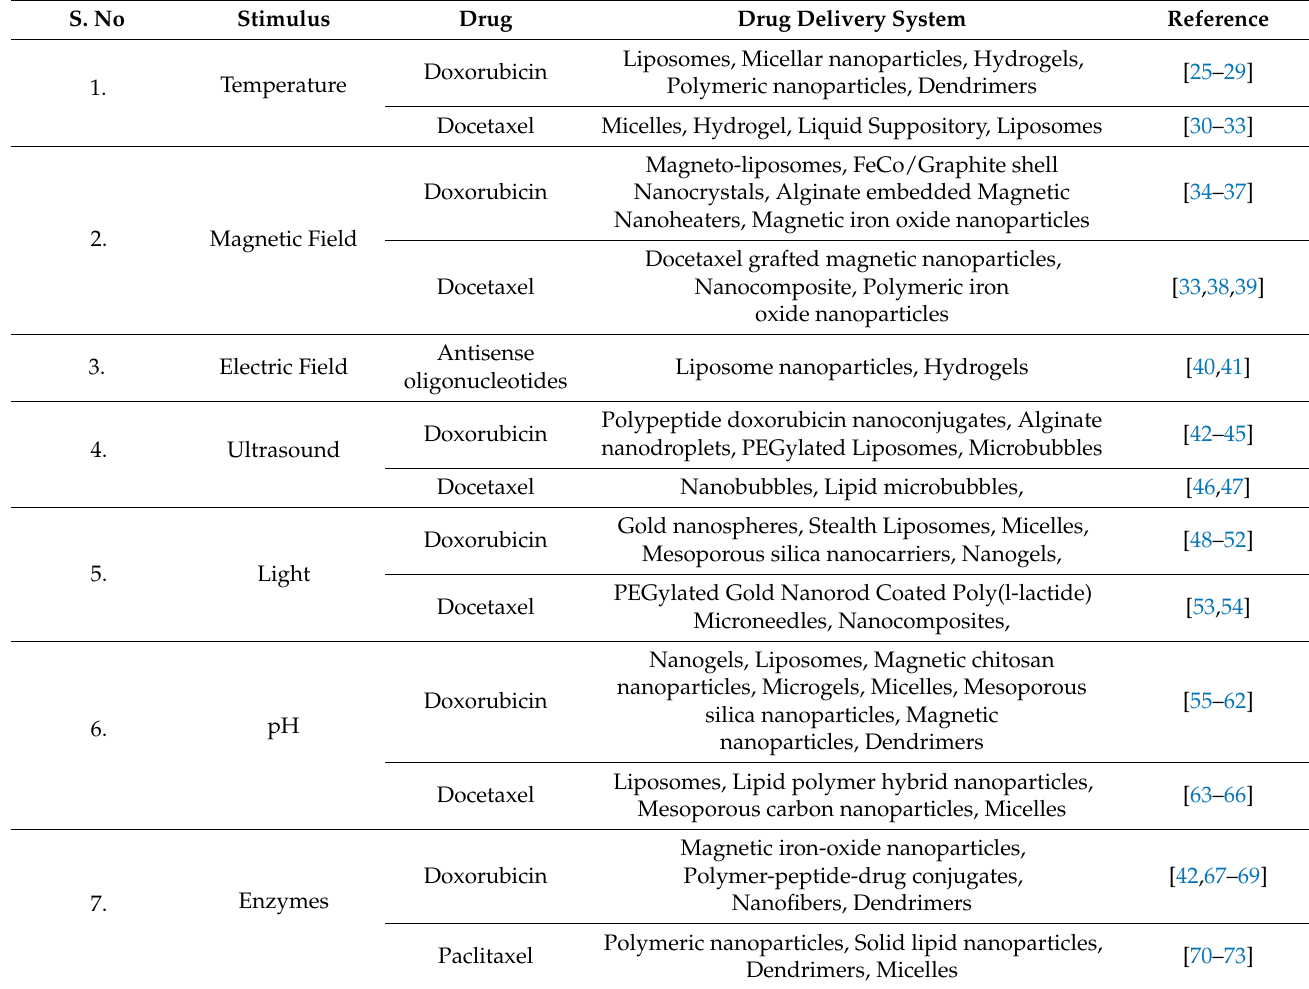
Table 1. Stimuli-Responsive Drug Delivery Systems for Cancer